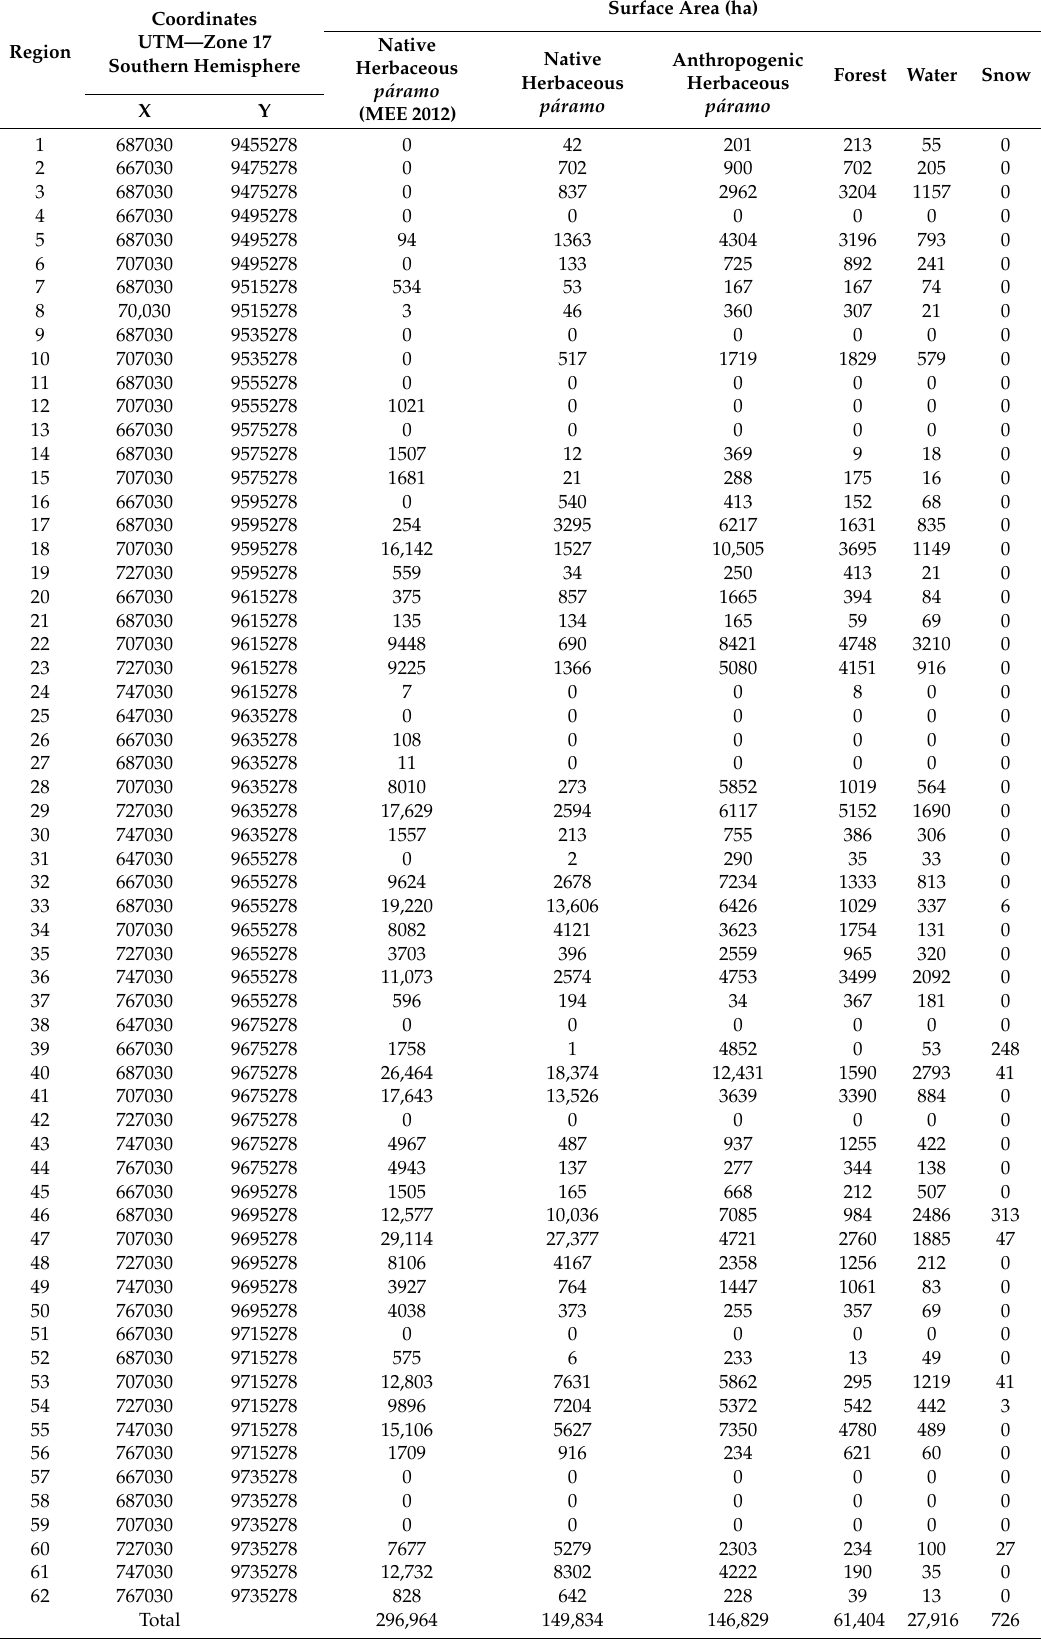
Table 4. The distribution of land use / land cover for the complete study area and each region.